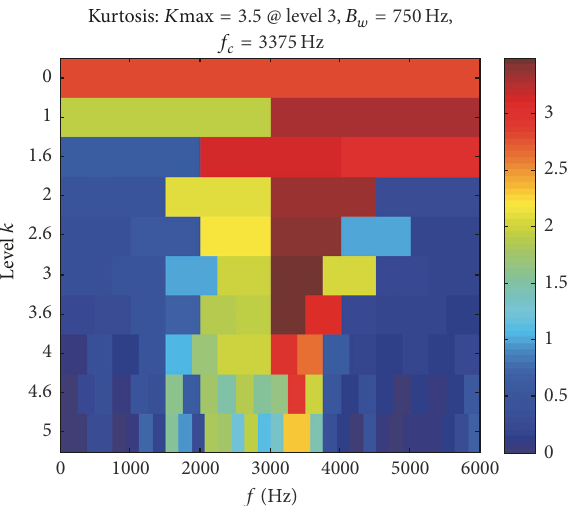
Figure 10: Processed results using fast kurtogram for detecting an outer race fault. Central frequency 𝑓 𝑐 = 3375 Hz, bandwidth 𝐵 𝑤 = 750 Hz, and level 𝑘 = 3 .